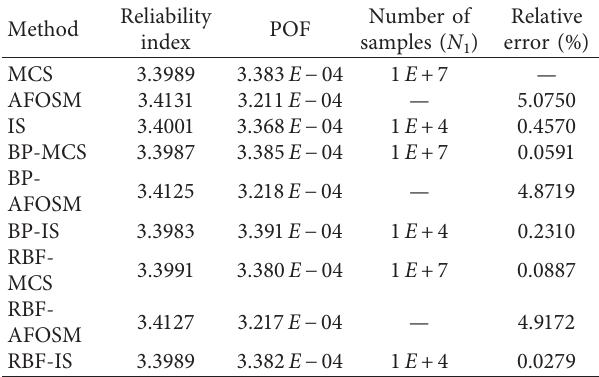
Table 6: Comparison of the reliability index and POF from dif- ferent reliability analysis methods with an ANN sample size of